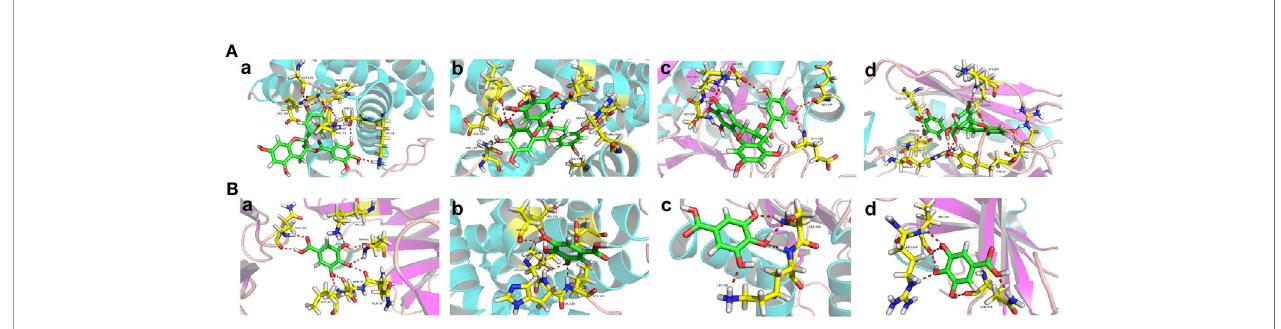
FIGURE 7 | The Binding Modes of Top Ingredients and Top Targets. (A) The binding modes of EGCG in the active pockets: a (BAX/PDB ID: 6EB6); b (BCL2/PDB ID: 4AQ3); c (CASP3/PDB ID: 6CL0); d (AKT1/PDB ID: 6HHG). (B) The binding modes of gallic acid in the active pockets: a (BAX/PDB ID: 5W5Z); b (BCL2/PDB ID: 5VAX); c (CASP3/PDB ID: 6CL0); d (AKT1/PDB